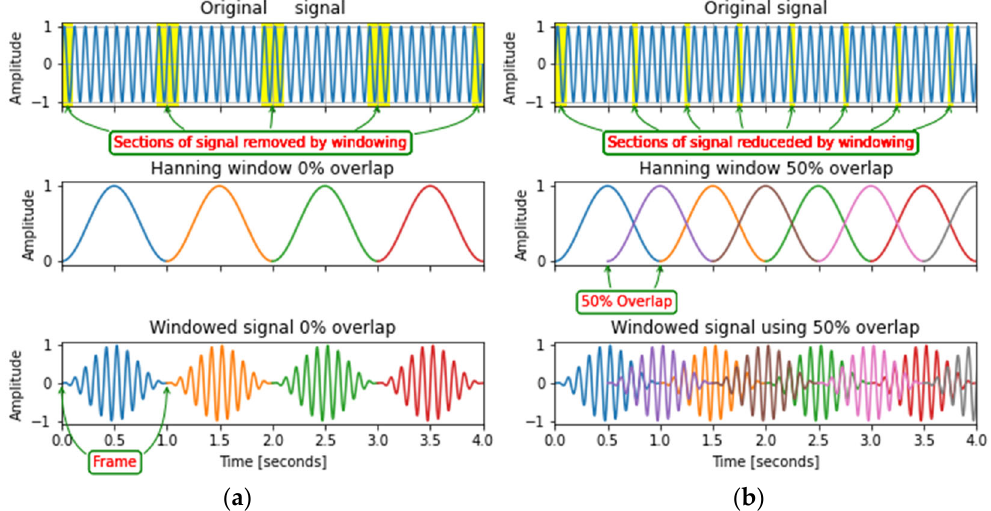
Figure 2. Illustration of the framing and windowing process using a Hanning window: ( a ) with 0% overlap; ( b ) with 50% overlap.